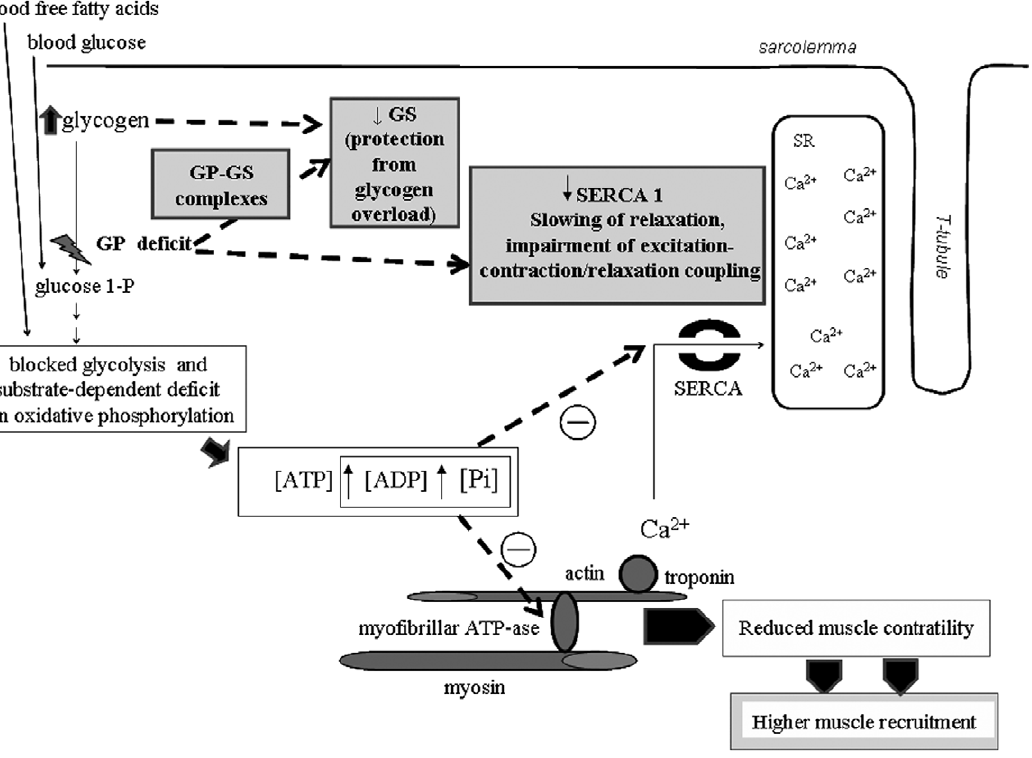
Figure 5. Schematic representation of the main findings and conclusions (in grey squares) of our study with regard to the pathophysiology of McArdle disease. Abbreviations: GS (glycogen synthase), GP [glycogen phosphorylase, muscle isoform (myopho- sphorylase)], SERCA1 (sarcoplasmic reticulum Ca 2 + -ATPase 1).